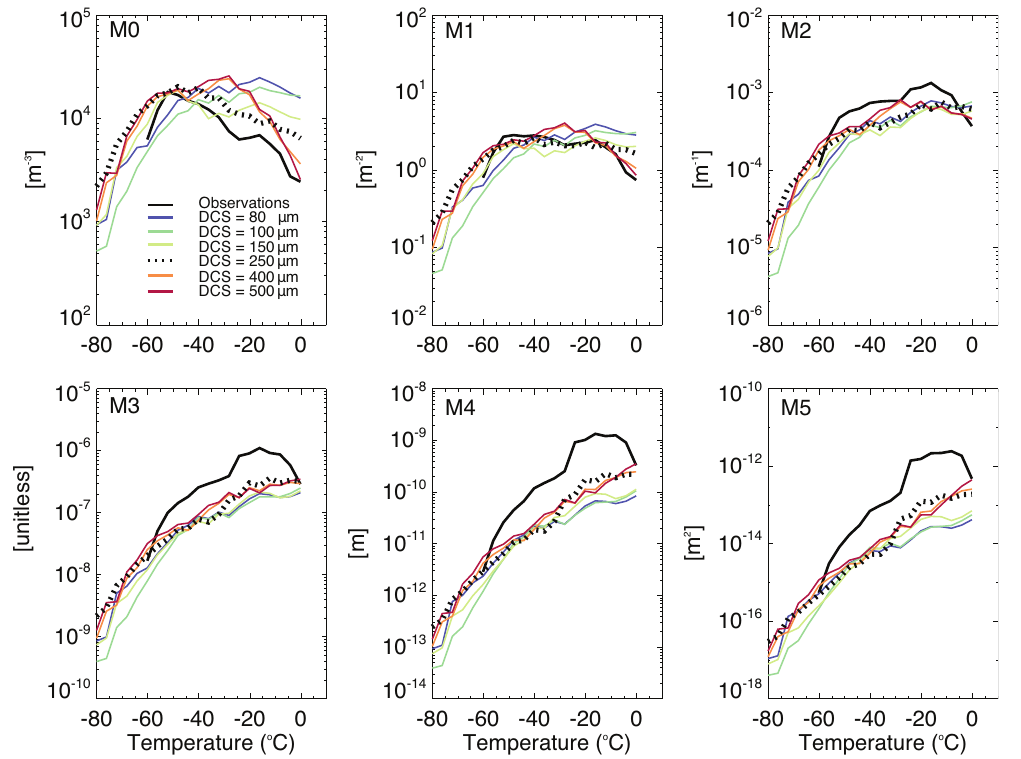
Fig. 11. Same as Fig. 5 (moments, TC4), but using different D cs values. 1061 Figure 11. Same as Fig. 5 (moments, TC4), but using different D cs values.